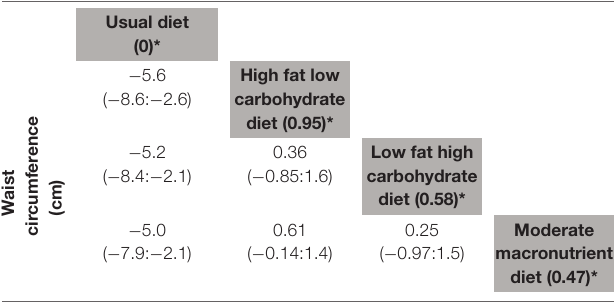
TABLE 2 | League table of network meta-analysis results of weight changes (Kg) and BMI changes (Kg/m 2 ) at study end ( ≥ 12 months).